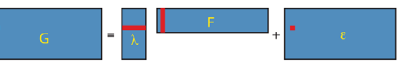
Figure 1. Low-dimensional matrix factorization via factor analysis. Each matrix in Equation 1 is illustrated by a blue rectangle and labeled. As in Equation 2, a single element of genotype matrix G , G i , j is shown in red, and is computed from the product of the appropriate factor loading and factor vectors plus the corresponding random error term (all highlighted in red).